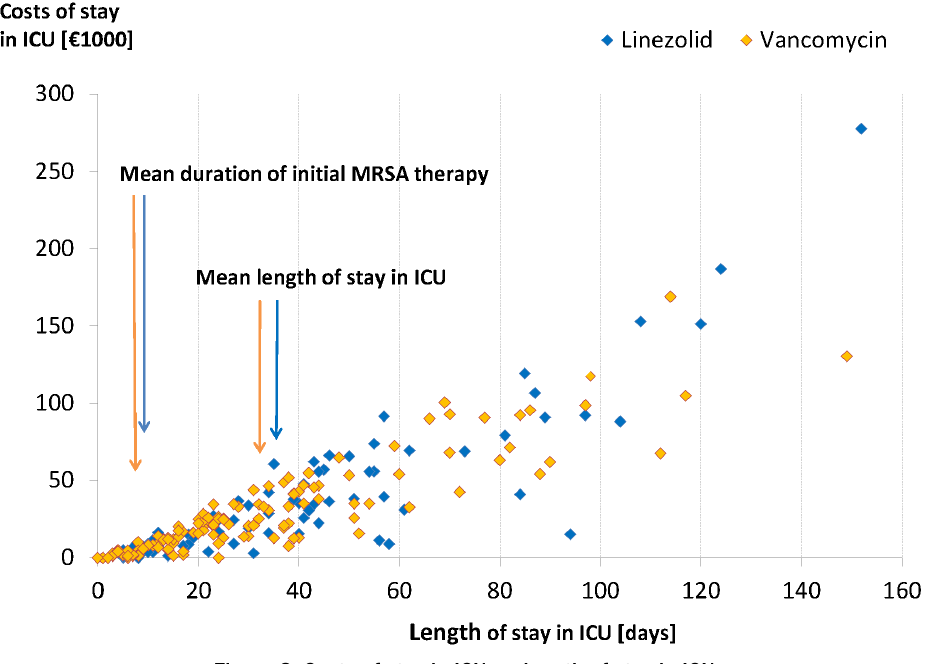
Figure 3: Costs of stay in ICU vs. length of stay in